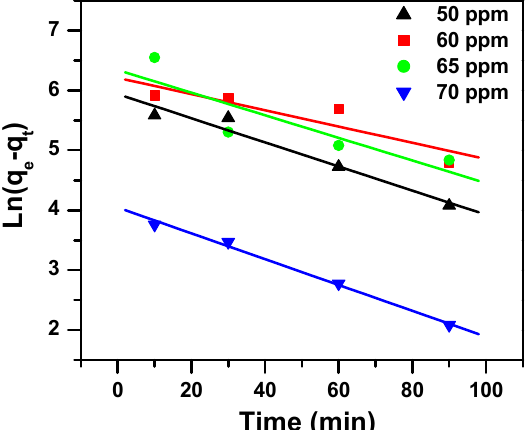
Figure 7. Pseudo-first-order model plot showing the effect of contact time and initial dye concentration on MB removal using Fe 2 (MoO 4 ) 3 .